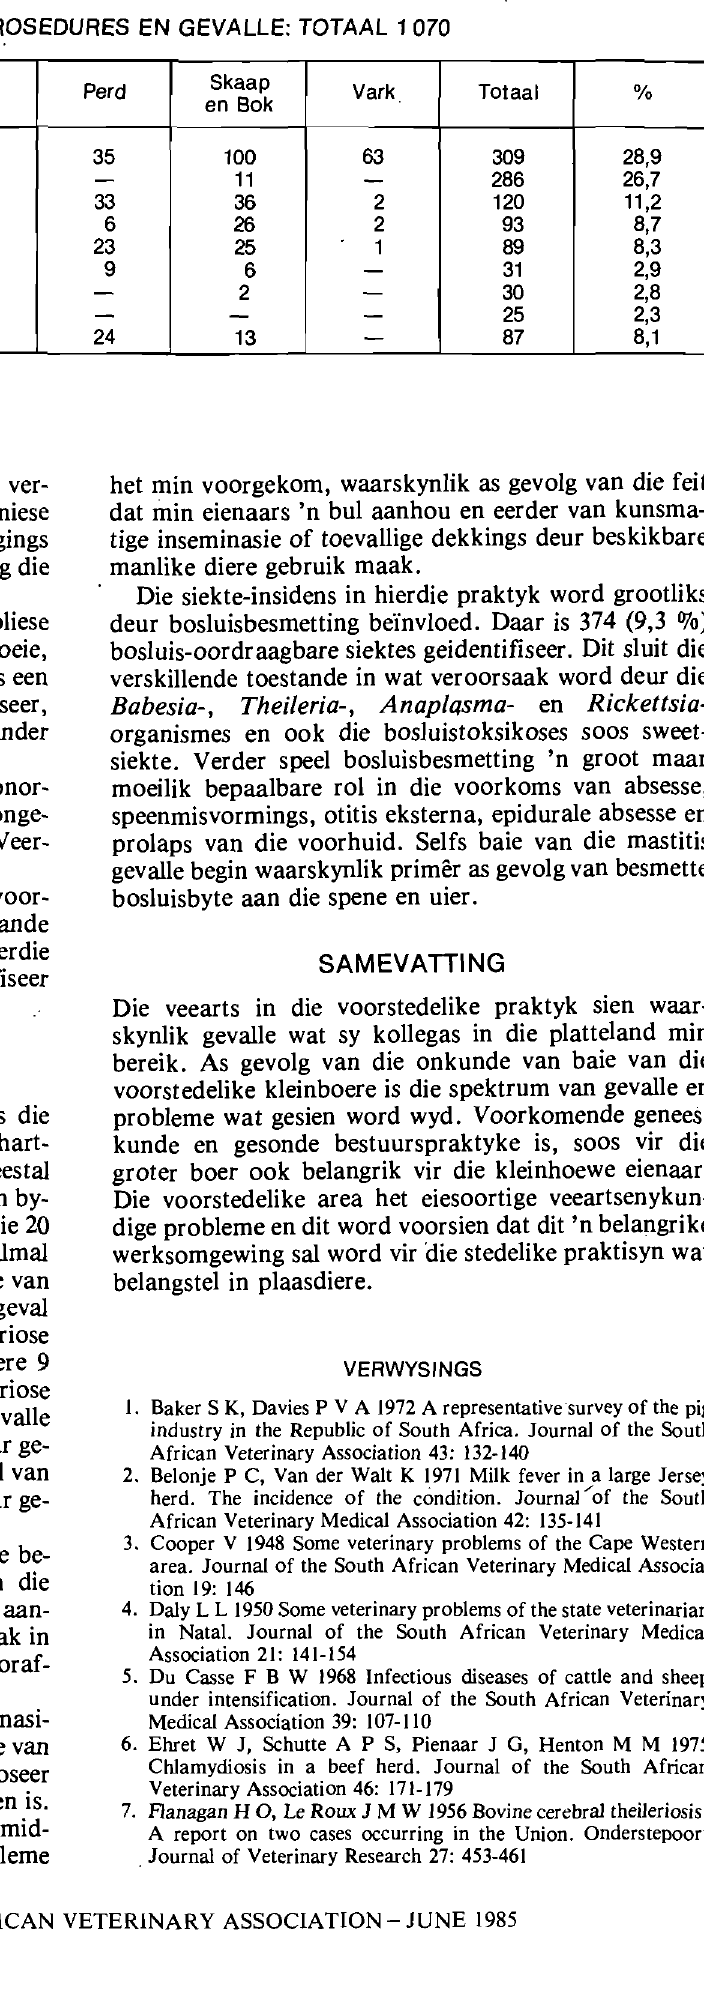
Tabel 7: CHIRURGIESE PROSEDURES EN GEVALLE: TOTAAL